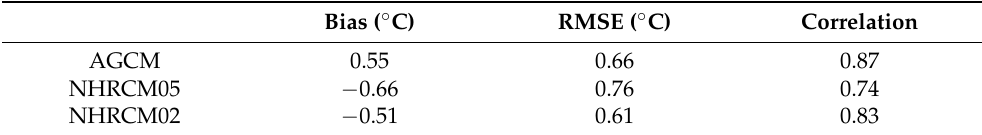
Table 3. Same as in Table 2 but for seasonal changes in 20-year mean monthly surface air temperature in three simulations against observation. See Figure 3 for seasonal changes. Bias (°C)